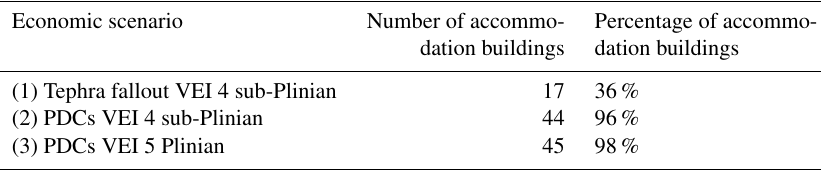
Figure 7. (a) Spatial distribution of the elements at risk in Vila Franca do Campo municipality (colour polygons) affected by tephra fallout resulting from a VEI 4 sub-Plinian eruption at Fogo volcano, considering the dominant winds for the summer period. (b) Spatial distribution of the elements at risk in Vila Franca do Campo municipality affected by tephra fallout resulting from a VEI 4 sub-Plinian eruption of Fogo volcano, considering the dominant winds for the winter period. UTM coordinates, zone 26S, datum WGS 84. Table 3. Number and percentage of buildings in each economic